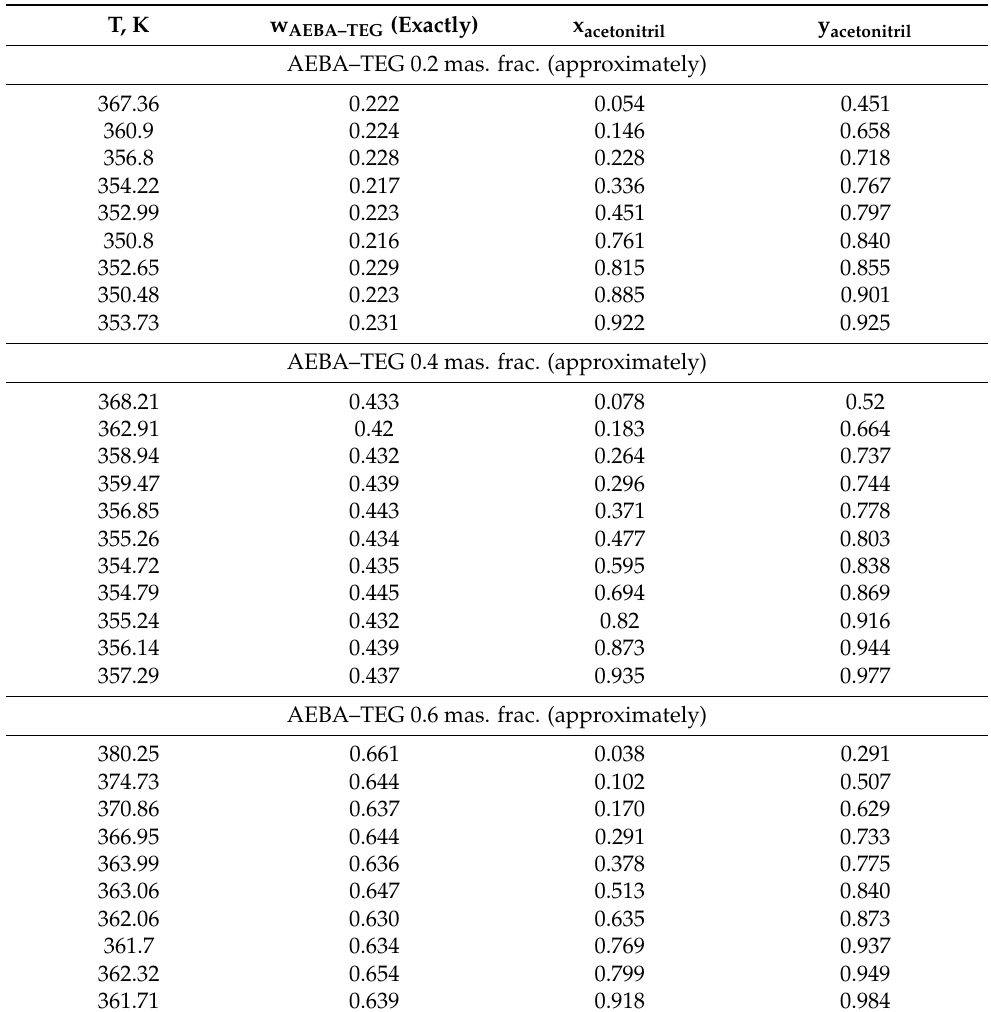
Table 1. Experimental TPXY data on vapor–liquid equilibrium for an acetonitrile–water mixture in the presence of AEBA–TEG at various